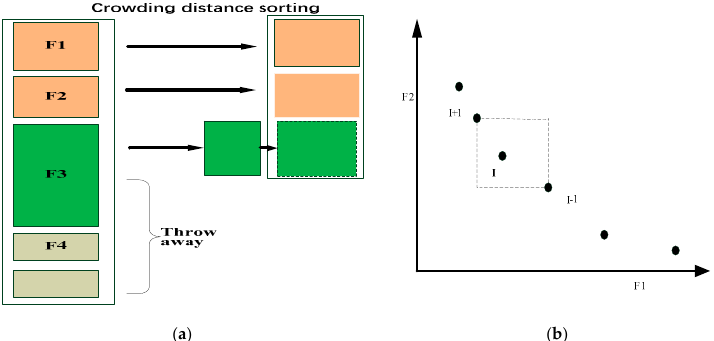
Figure 1. ( a )Crowding distance procedure; ( b ) Crowding distance calculation. Figure 1. ( a ) Crowding distance procedure; ( b ) Crowding distance